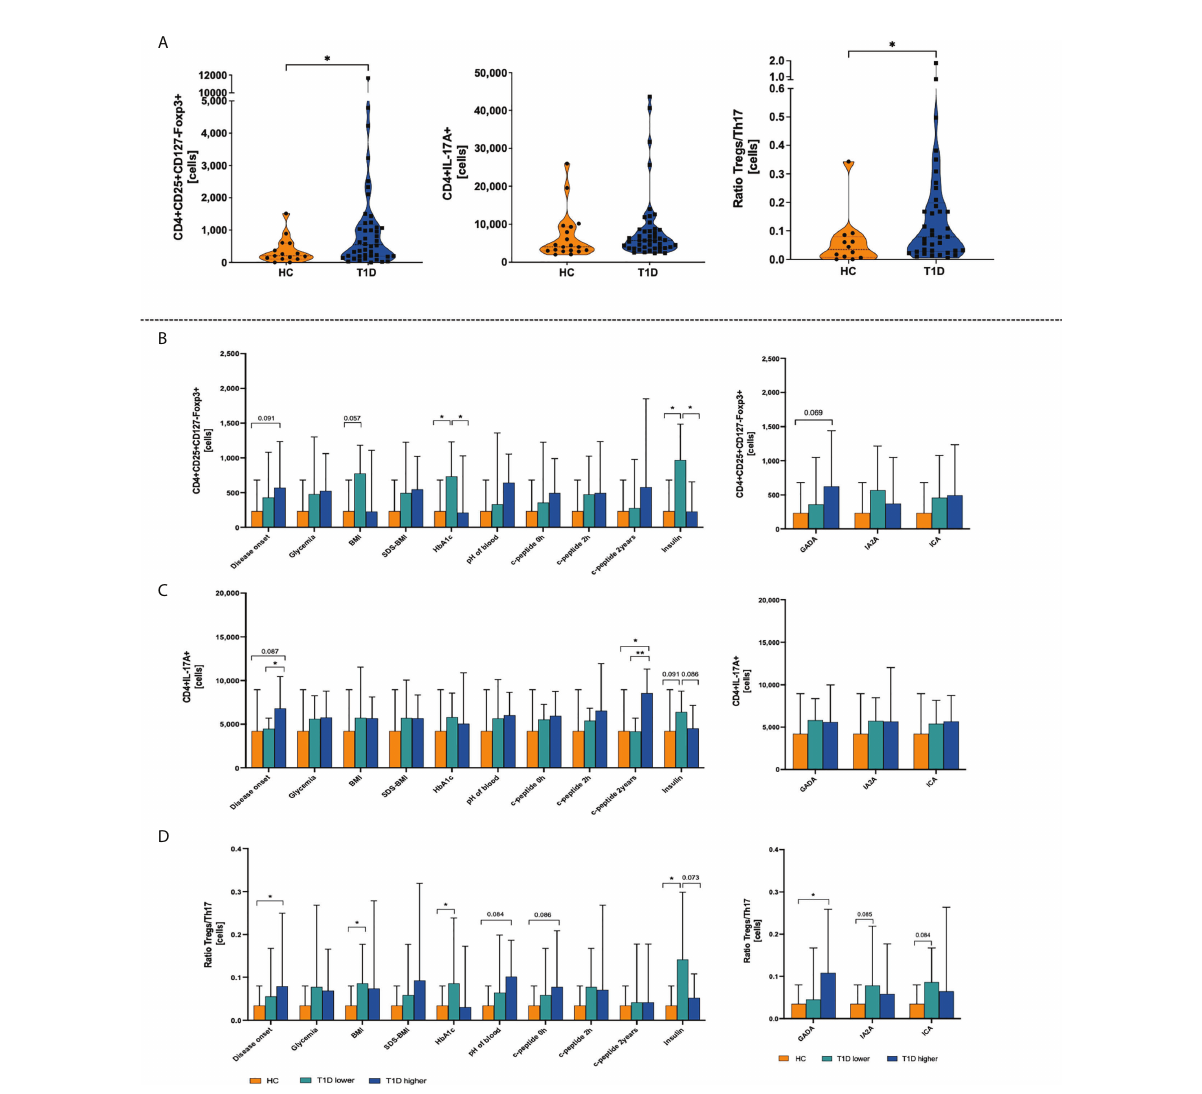
FIGURE 1 Differences between type 1 diabetes patients (T1D) and healthy control group (HC) in the absolute numbers of regulatory T and Th17 cells. Absolute numbers of T regulatory and Th17 cells, and Treg/Th17 ratio (A) . Strati fi cation of patients on the basis on the medium value of clinical parameters (T1D lower-values below the median; T1D higher-values upper median) and demonstration of Treg (B) , Th17 (C) , and Treg/Th17 ratio (D) . The levels of signi fi cant differences were indicated with asterisks or exact p values: * - p < 0.05; ** - p <